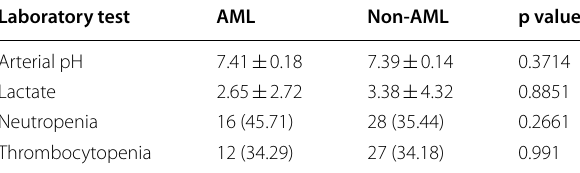
Table 2. Laboratory test results on admission to